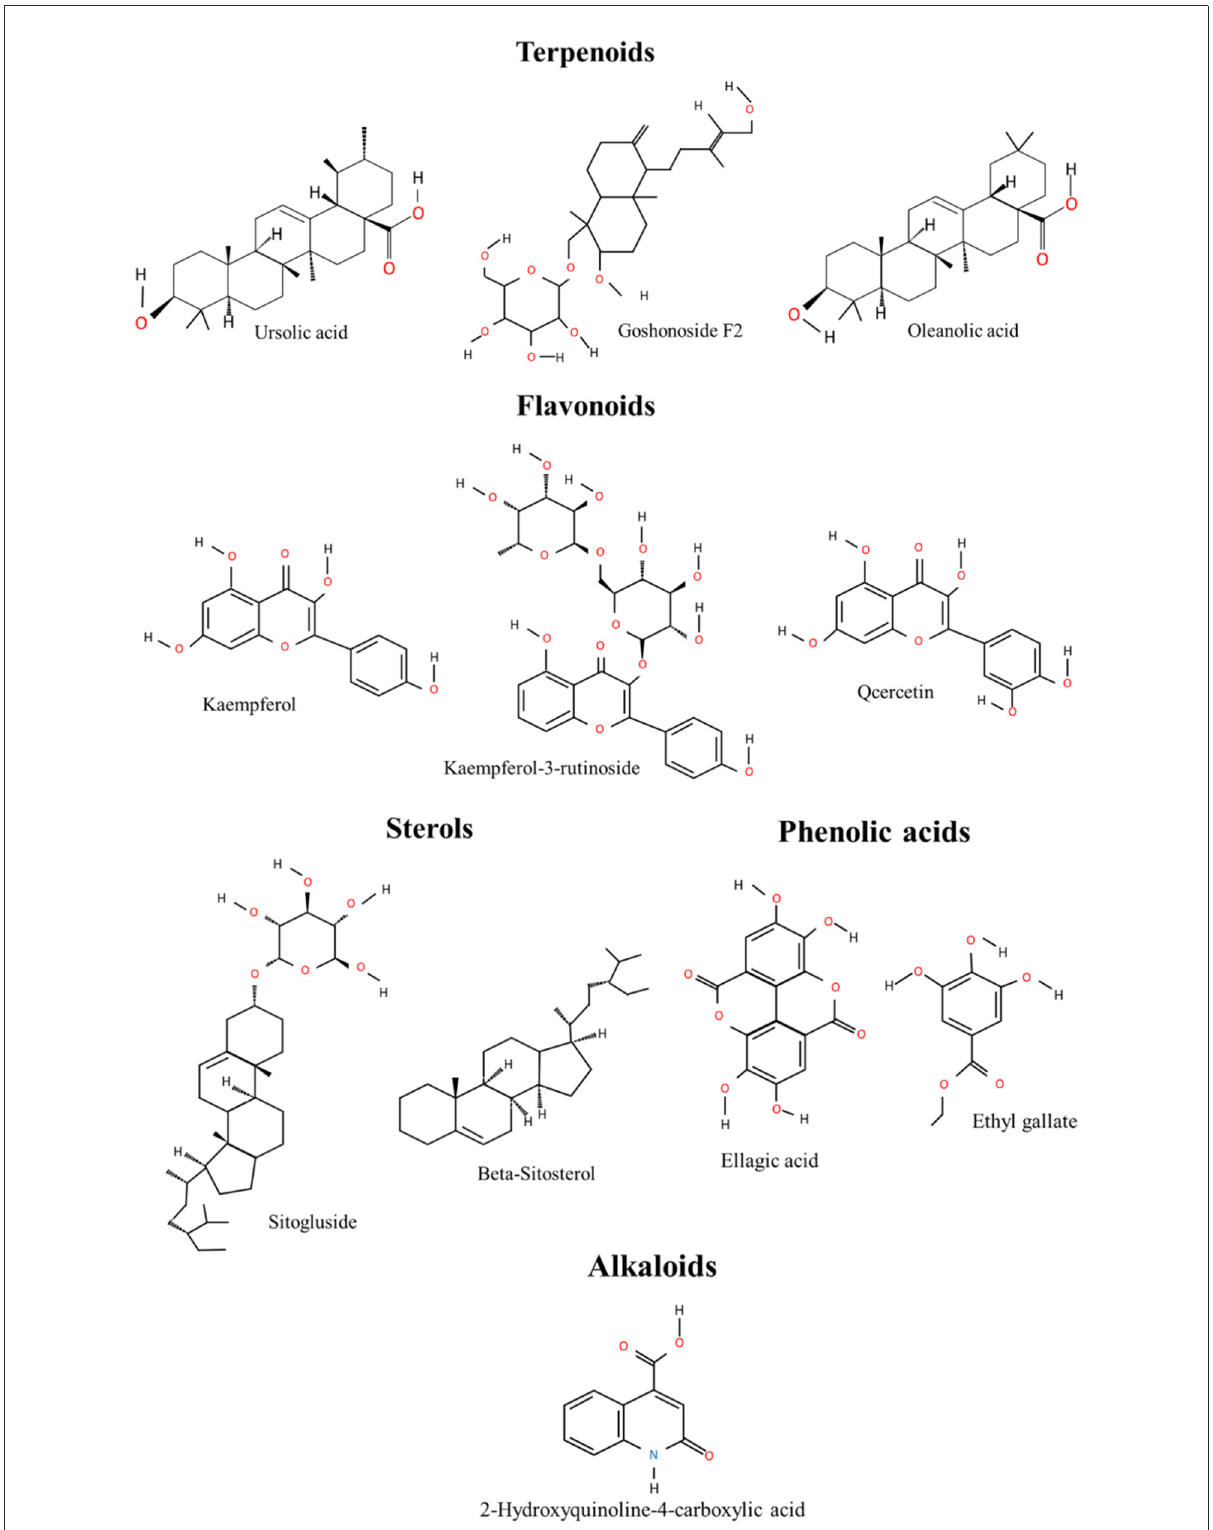
FIGURE3 Main compounds chemical structures in R.chingii